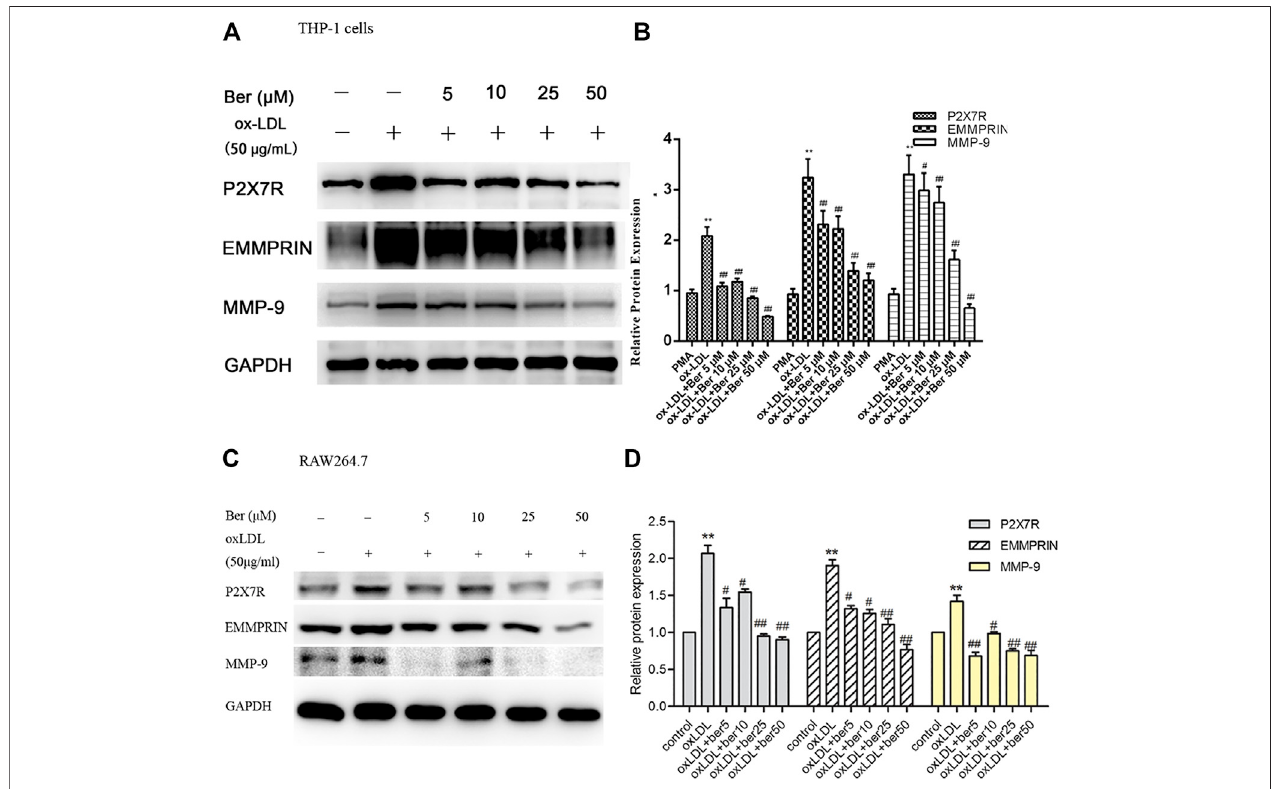
FIGURE 4 | Effect of berberine (5 – 50 μ M) on P2X7R, EMMPRIN, and MMP-9 expression (A) and (B) in THP-1 cells, (C) and (D) in RAW264.7 cells). Densitometry measurements of P2X7R, EMMPRIN, and MMP-9 were normalized to GAPDH. The band densities were measured by Quantity One 1D analysis software. The data (means ± SD)wereobtainedfrom three independentexperiments. ** p < 0.01comparedwithPMA or control, #: p < 0.05, ##: p < 0.01comparedwith